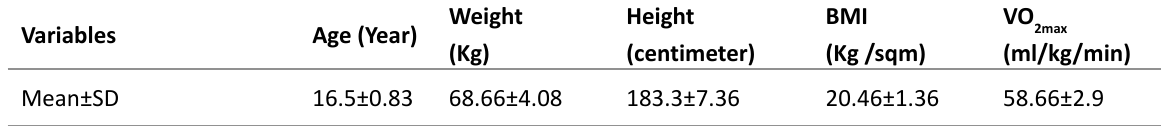
Table 1. Mean and standard deviation of individual characteristics of subjects Variables